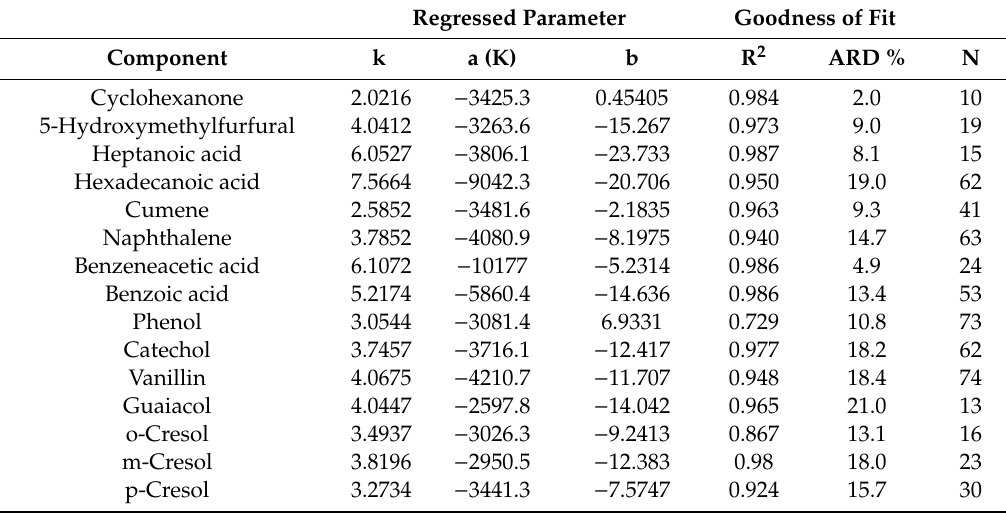
Table 10. Chrastil solubility constants (k, a, b) for the binary systems of bio-oil components and sCO 2 , statistical properties of the regression (R 2 , ARD), and number of experimental data regressed